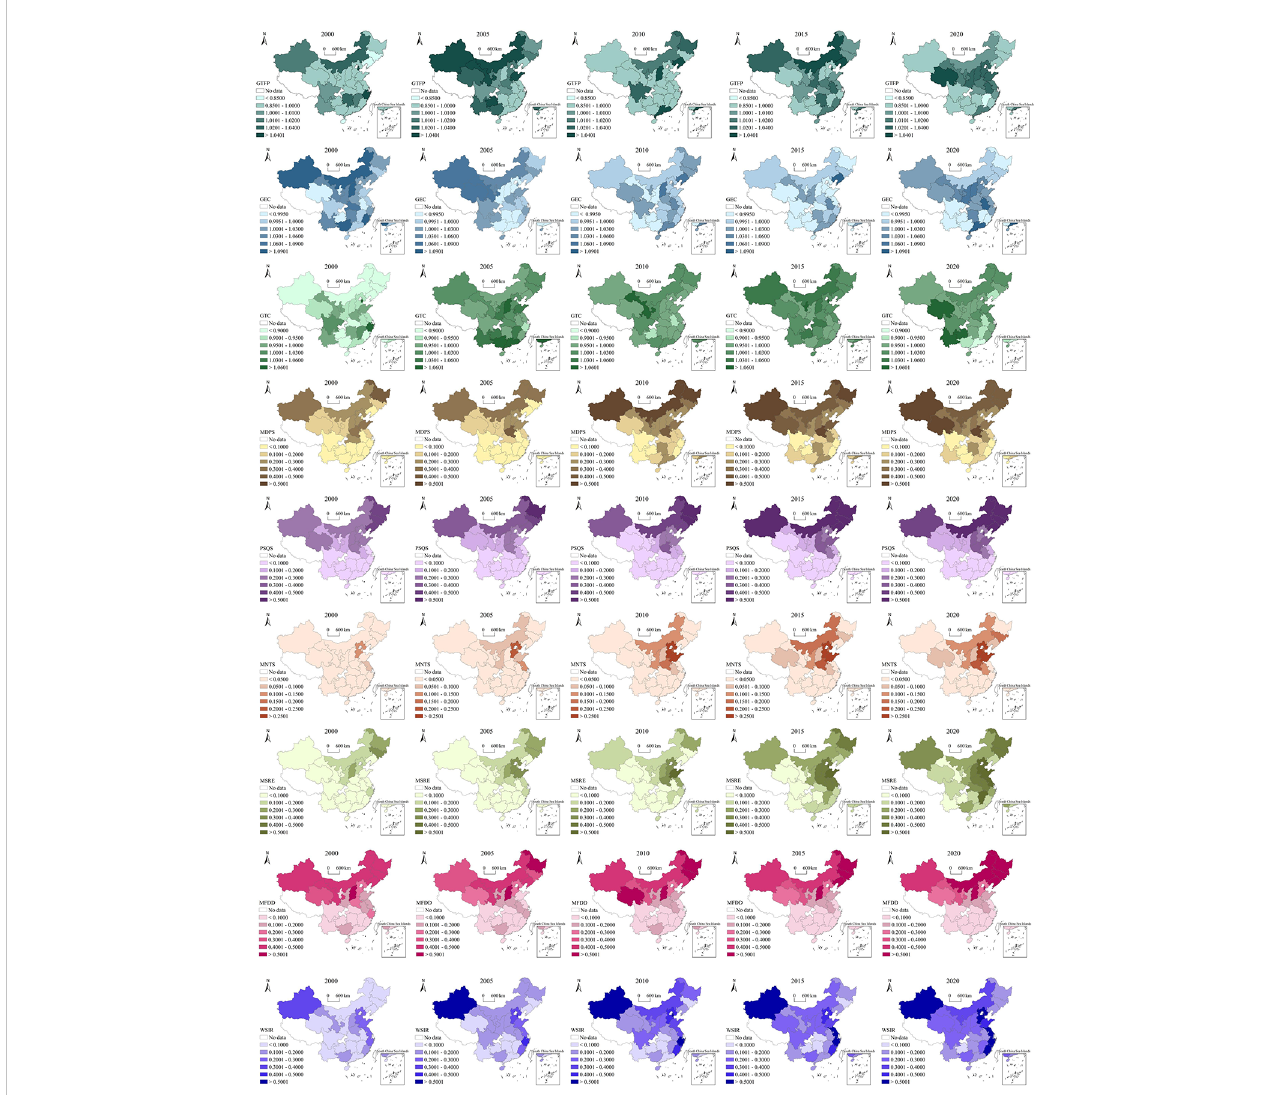
FIGURE 3 Spatial-temporal pattern of GTFPG, GECG, GTCG and green technologies from 2000 to